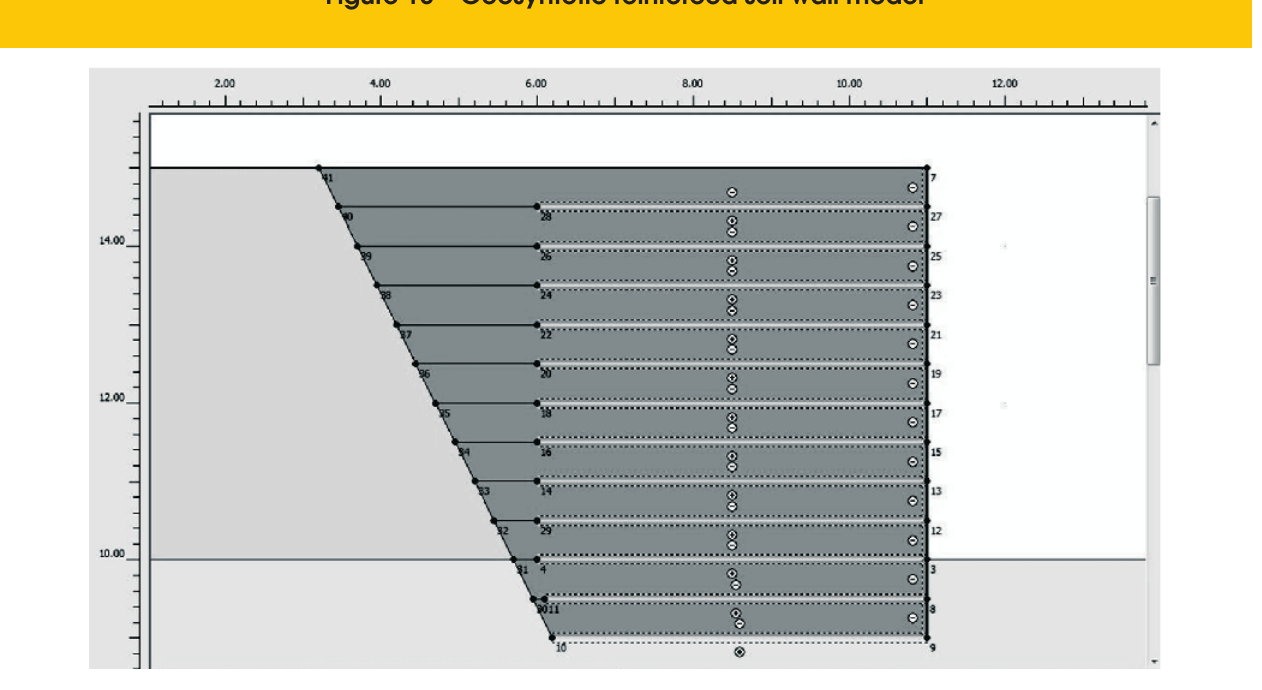
Figure 10 – Geosyntetic reinforced soil wall model